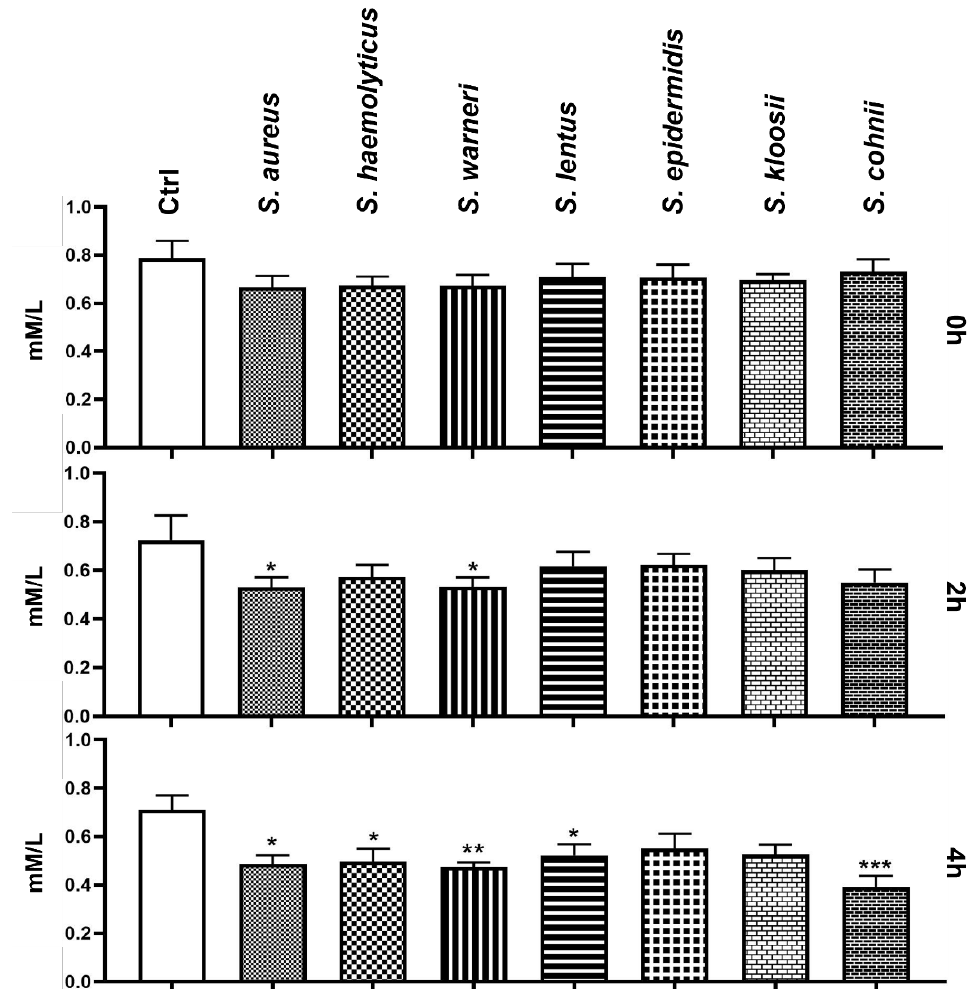
Figure 6. Changes in concentration of extracellular Mg during the 4 h bacteria/sperm co-incubation in vitro at 37 °C. Each group treated with Staphylococcus species was compared with the Ctrl group with no added bacteria. Each bar represents the mean concentration of extracellular Mg ± S.E.M.